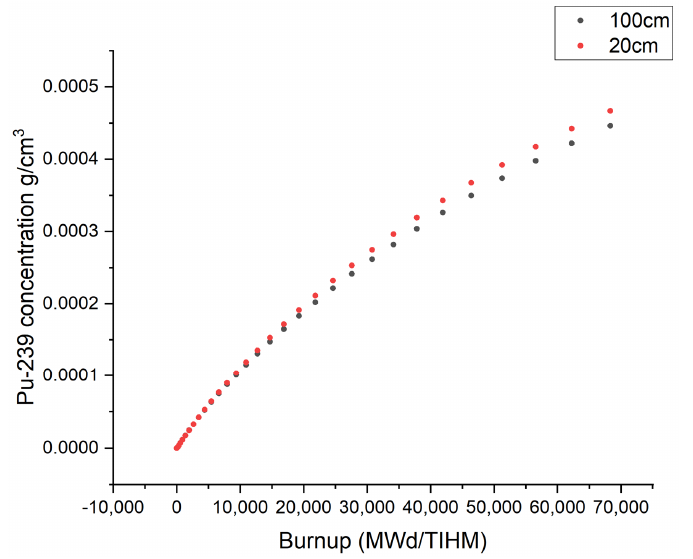
Figure 10. Pu-239 concentration across a burnup cycle ending at 70 GWd/tU, averaged across the whole pin. The two different models are referred to by their seed and blanket region sizes of 20 cm and 100 cm. The difference in plutonium production is similar at low burnup, but at higher burnup the 20 cm seed/blanket model produces more Pu-239.